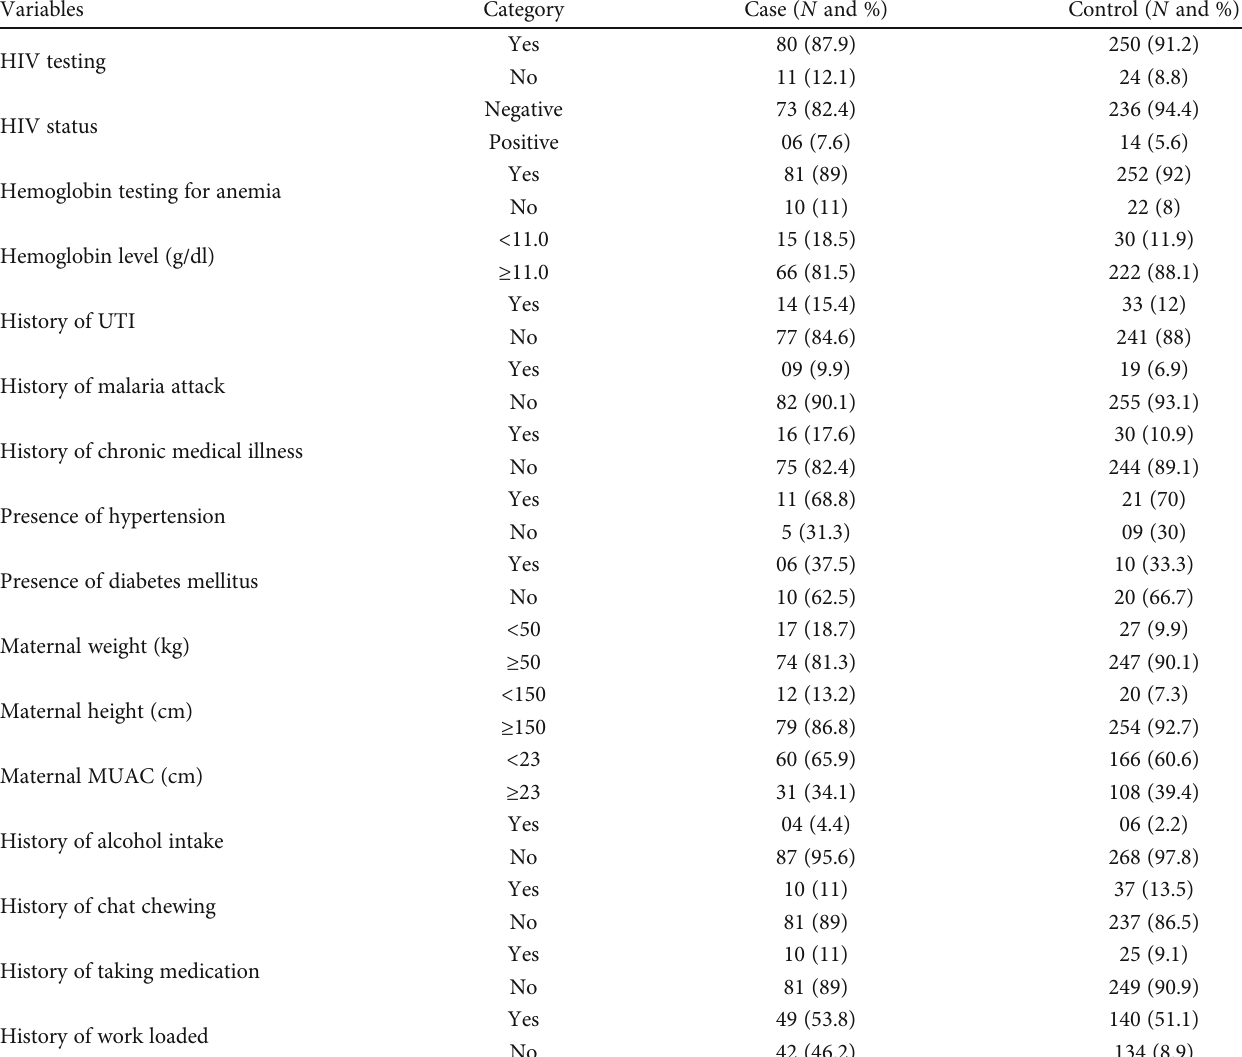
Table 3: Preexisting medical disorder and physical and lifestyle characteristics of mothers who gave birth in Silte Zone Public Hospitals, Southern Ethiopia